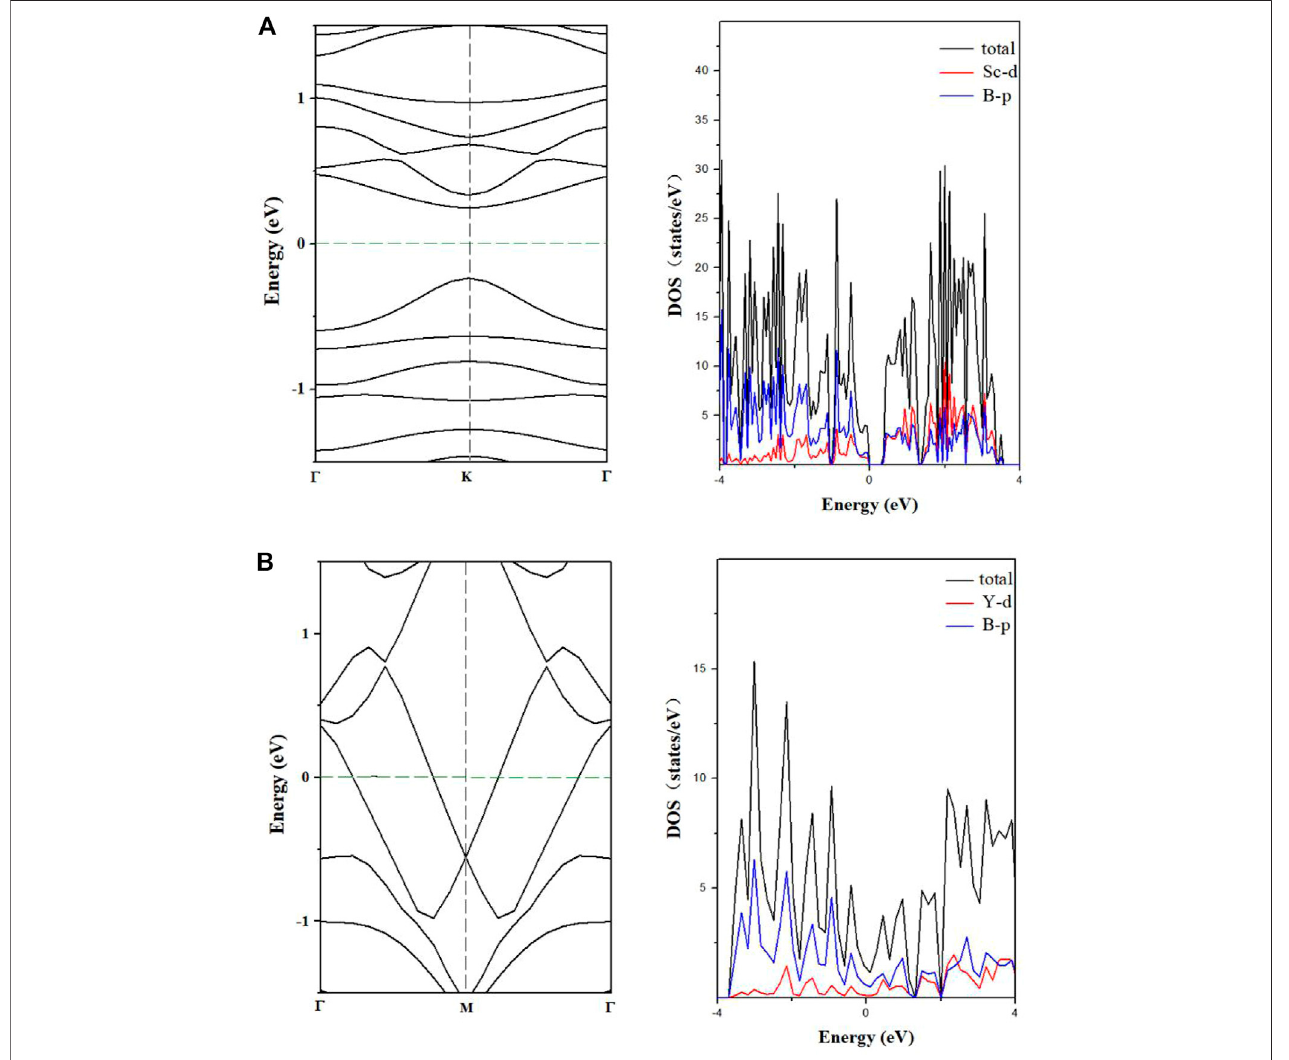
FIGURE 5 | Energy band and density of states of 1D-Sc 4 B 24 (A) , 1D-Y 2 B 12 (B) nanowires predicted by PBE.